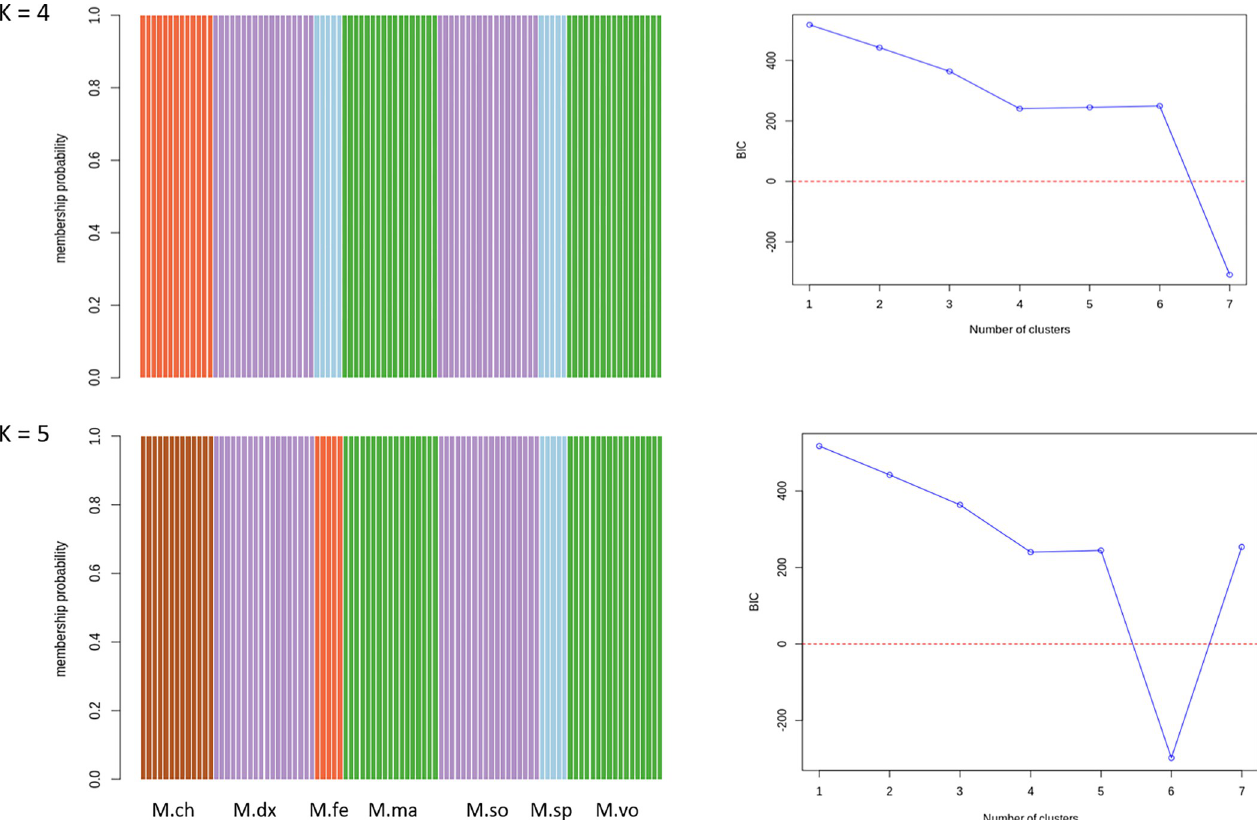
Fig 7. Cluster membership classification of Macrobrachium species and the Bayesian information criterion (BIC) plot obtained from the full set SNPs (N = 1,814) using the Adegenet package assuming four (K = 4) and five (K = 5) populations. Each bar in the admixture plot (left) represents an individual: M.ch– M . chevalieri; M.dx– M . dux; M.so –M . sollaudii; M.fe –M . felicinum; M.sp –M . sp; M . ma–M . macrobrachion; M.vo –M . vollenhovenii